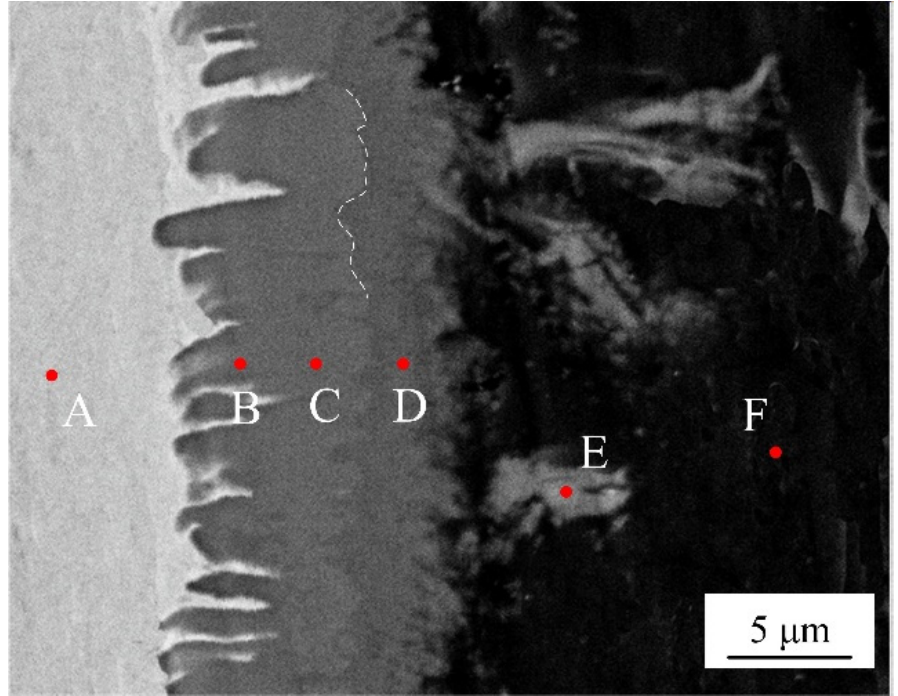
Figure 5. SEM image of selected locations (spots A~F) for EDS analysis. Table 3. Chemical composition of selecting spots in Figure 4. Spot Al (at. %) Fe (at.